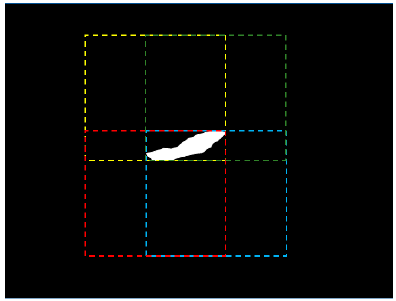
Figure 9. Patch generation of each potential landslide in four directions (labeled in each color), wherein white contour regions represent potential landslides.